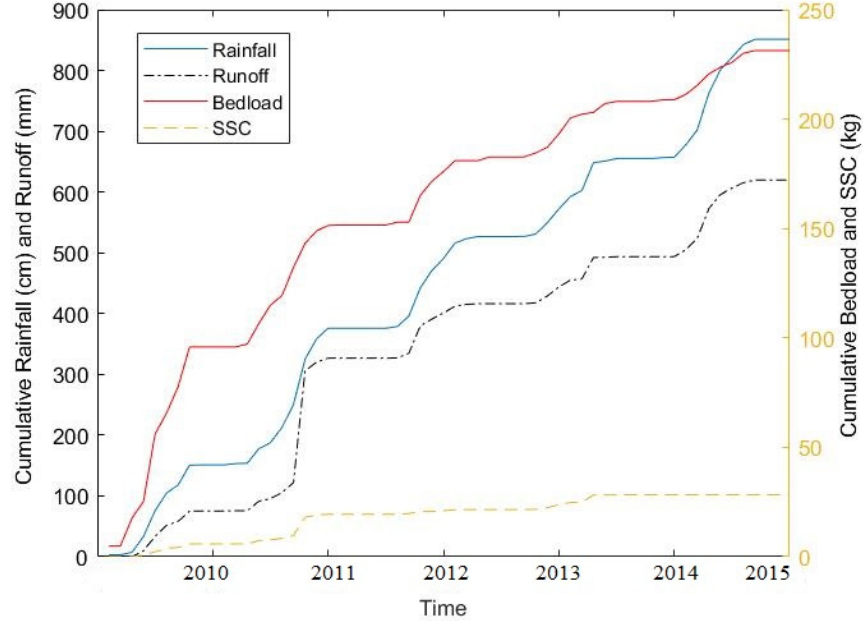
Figure A3. Cumulative monthly rainfall, runoff, bedload and suspended sediment.